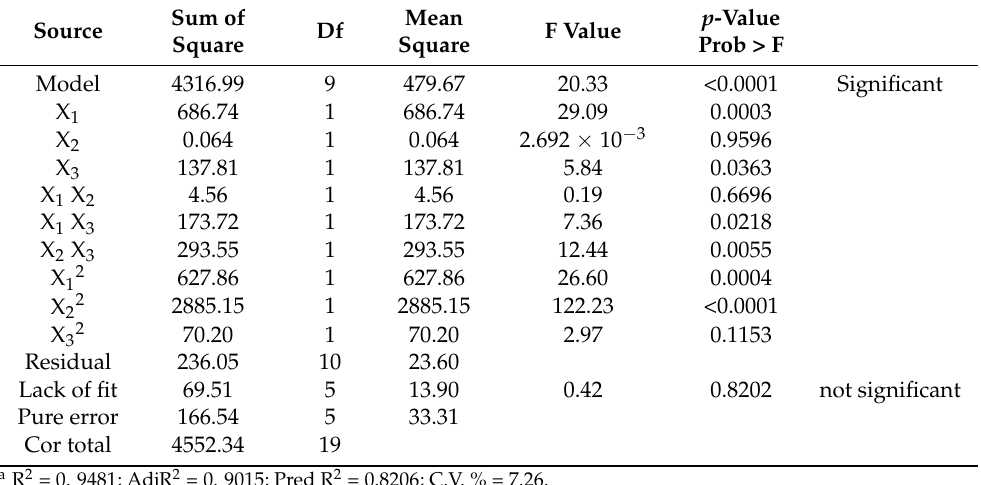
Table A1. ANOVA for response surface quadratic model a .